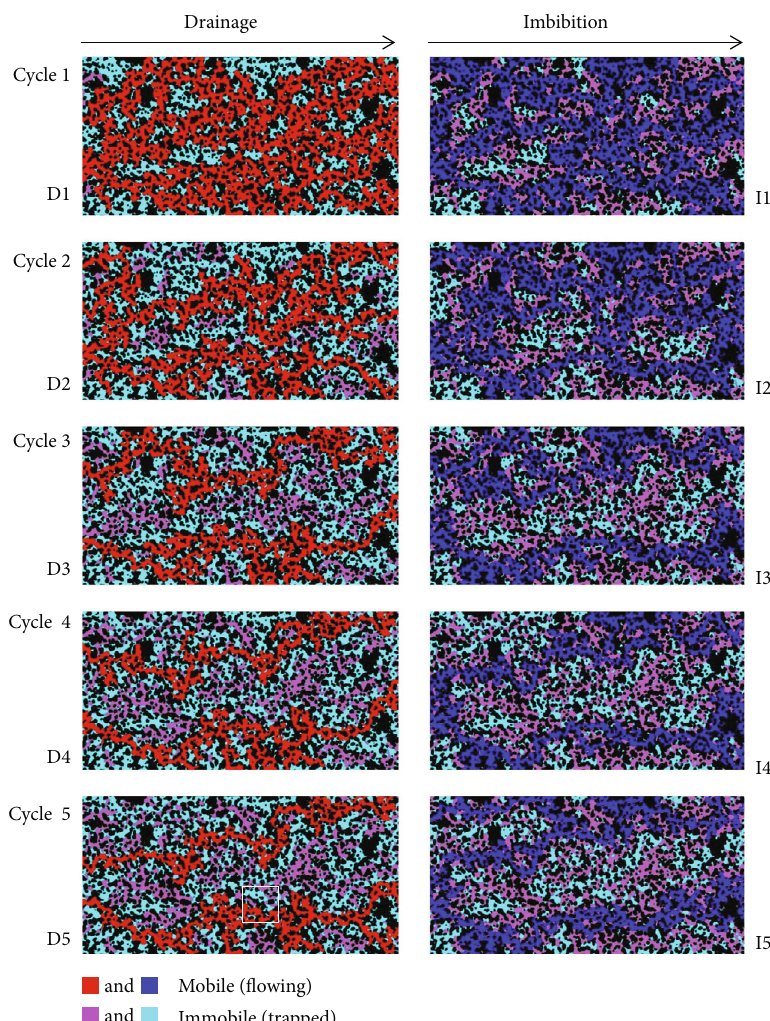
Figure 5: Sequential images of steady-state distribution of fl uids in the micromodel after the completion of each injection cycle (mobile ( fl owing) hexane and water injected during drainage and imbibition cycles, respectively; immobile (trapped) hexane and water). The magni fi ed image of the region marked with a white square in D5 is shown in Figure